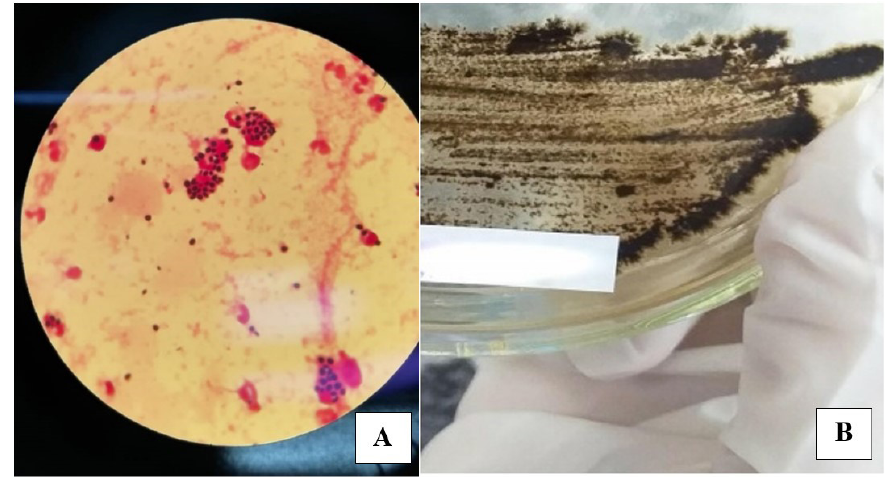
Figure 1. Citology and fungal culture . Note 1A. Direct cytology of a feline lesion performed with Gram stain and 100X objective, showing oval yeast structures compatible with Sporothrix spp. 1B. Macroscopic aspect of the fungus Sporothrix spp. isolated in a Petri dish containing Sabouraud Dextrose agar. Sample collected from a